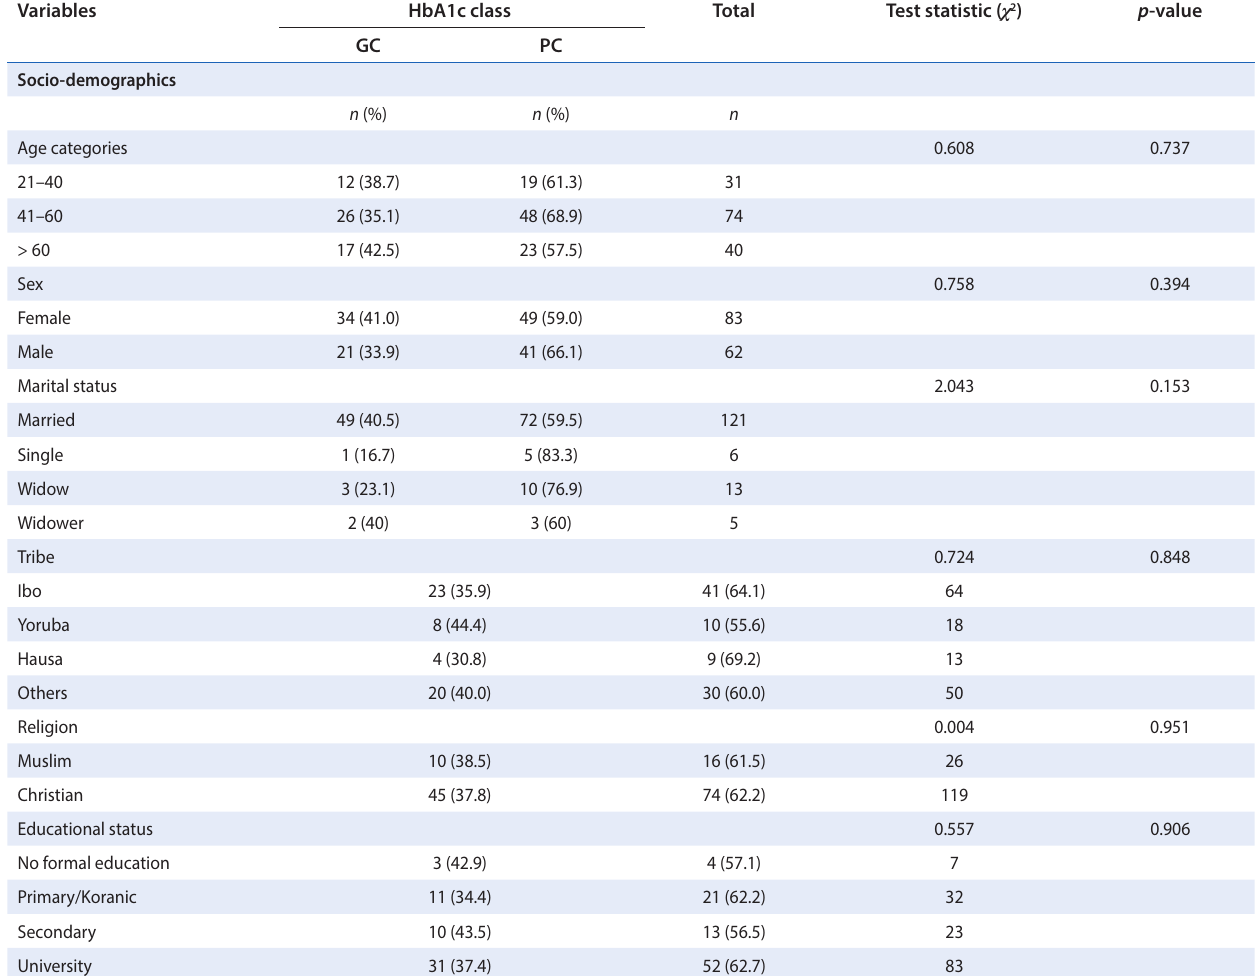
Table 3: The relationship between socio-demographics characteristics and type 2 diabetes control